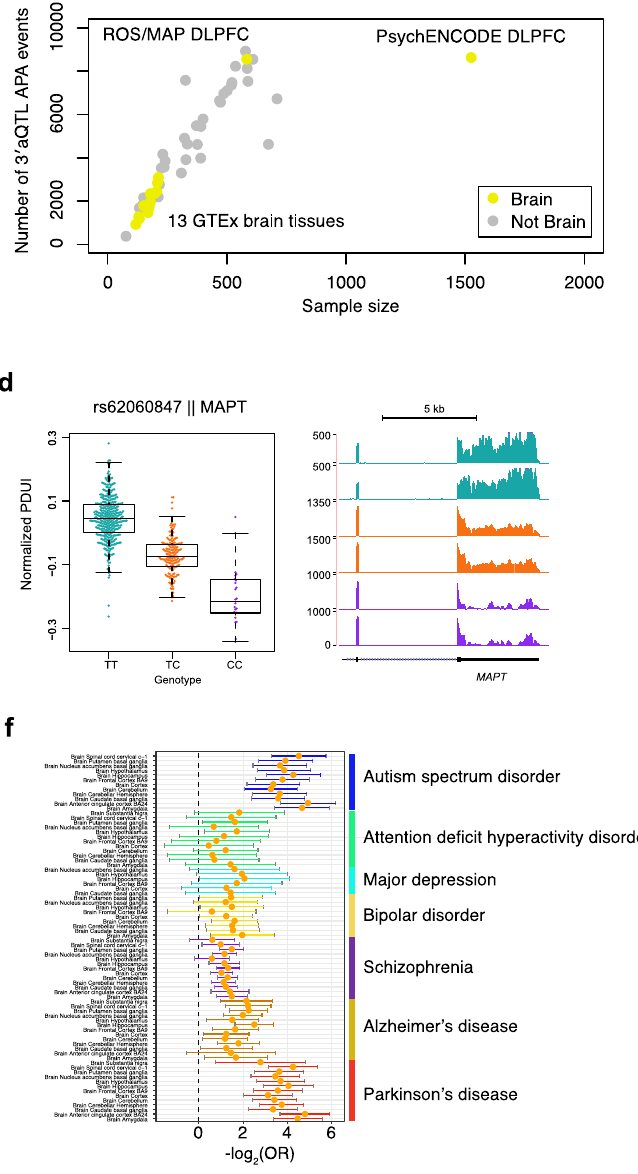
Nature Communications| (2023) 14:583